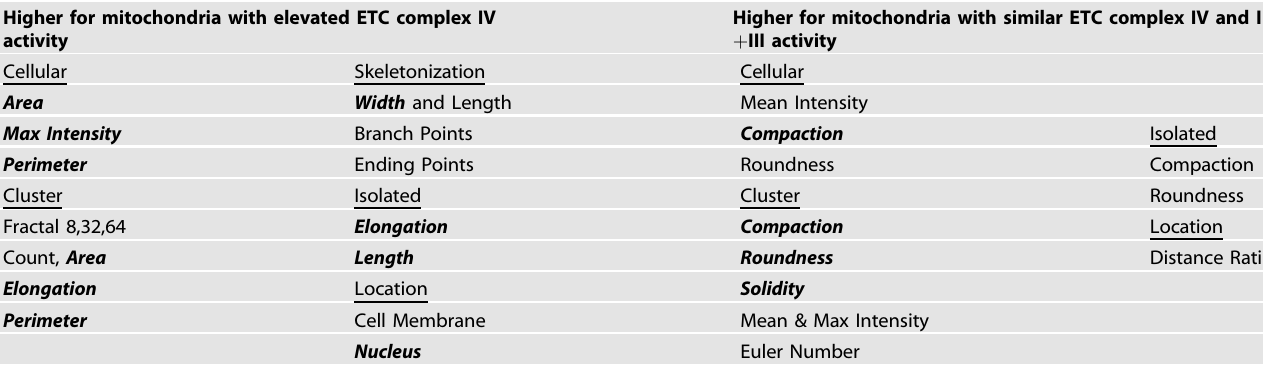
Table 7. Morphological parameters from Table 6 which have higher values organized by ETC complex IV